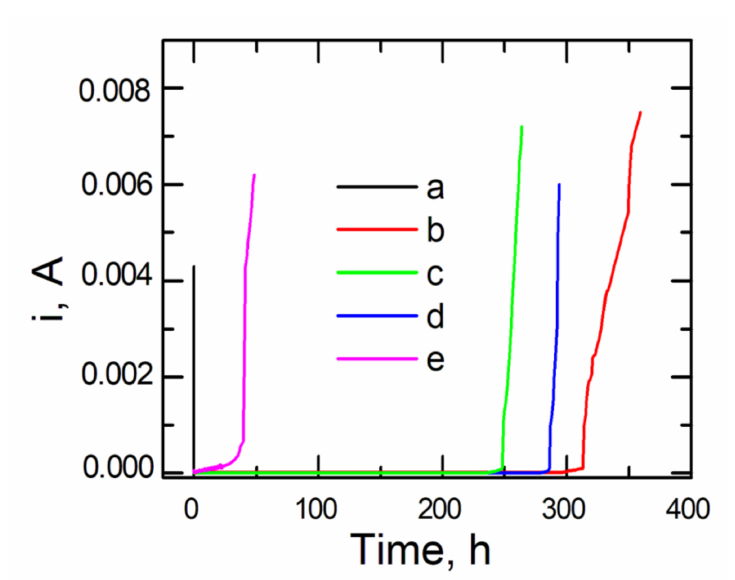
Figure 8. Chronoamperometric curves recorded in a chloride solution (0.5 mol dm − 3 Na 2 SO 4 +